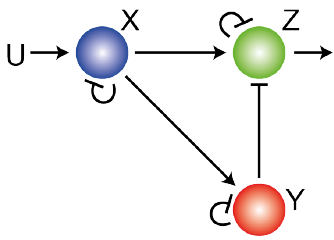
Figure 2. Adaptation through feedforward regulation. Three node network showing an incoherent feedforward network that can provide perfect